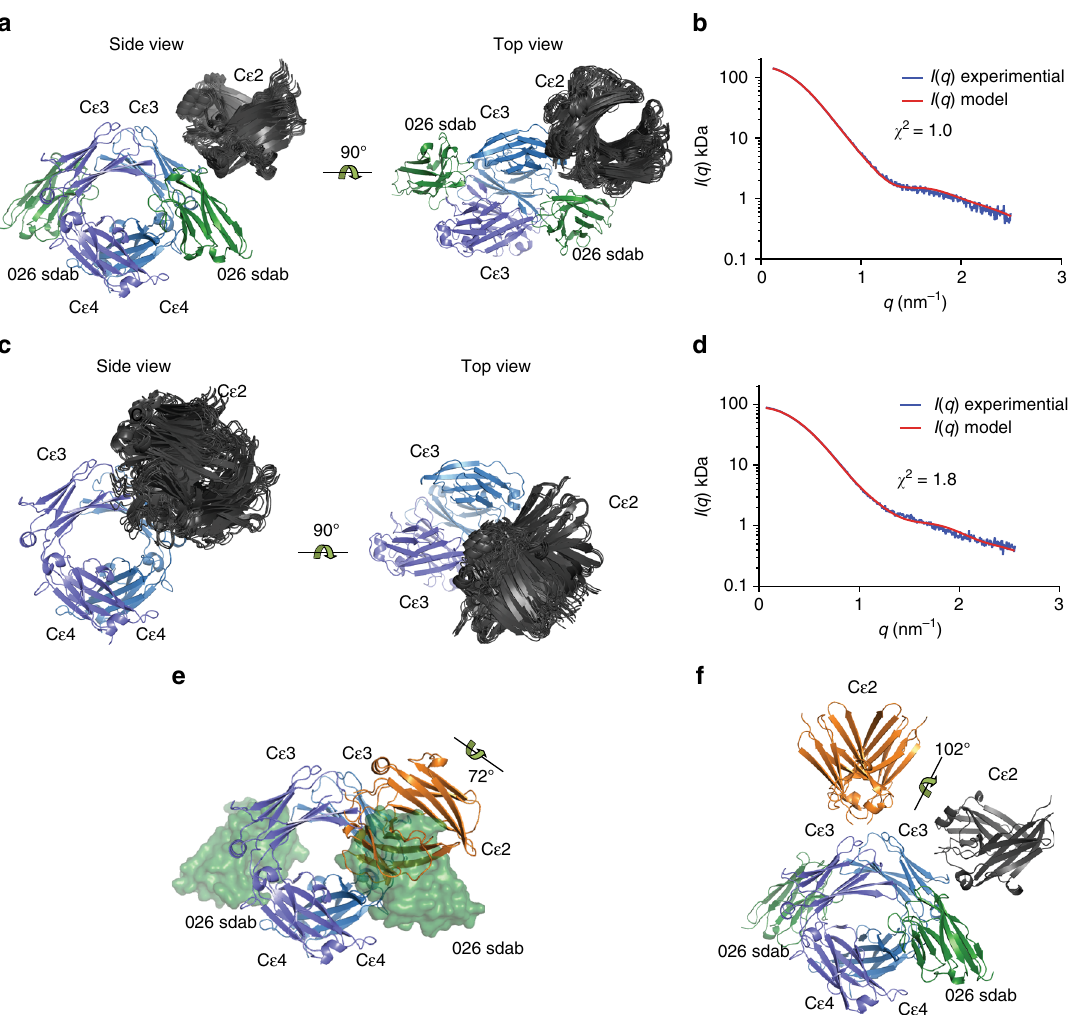
Fig. 5 SAXS analysis of the IgE Fc:026 sdab complex and unbound IgE Fc. a Side and top views of 20 superimposed rigid body models obtained with 026 in green, the C ε 3 and C ε 4 domains in blue, and the C ε 2 domains in gray. b The fi t of the scattering curve calculated from a representative rigid body model to the experimental curve as output from CORAL. c , d Same as panels a , b , but for the unbound Fc with the C ε 3 domains in the closed conformation. e In the fully bent conformation of free IgE Fc (PDB ID: 2WQR) the C ε 2 domains (orange) would substantially overlap with the location of sdab 026. f Comparison of the extended IgE Fc conformation (C ε 2 in orange, PDB ID: 4J4P) and the half-bent conformation of the Fc in complex with sdab 026 observed by SAXS (C ε 2 in